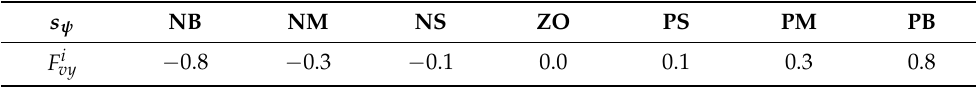
Table 2. The fuzzy rules for the